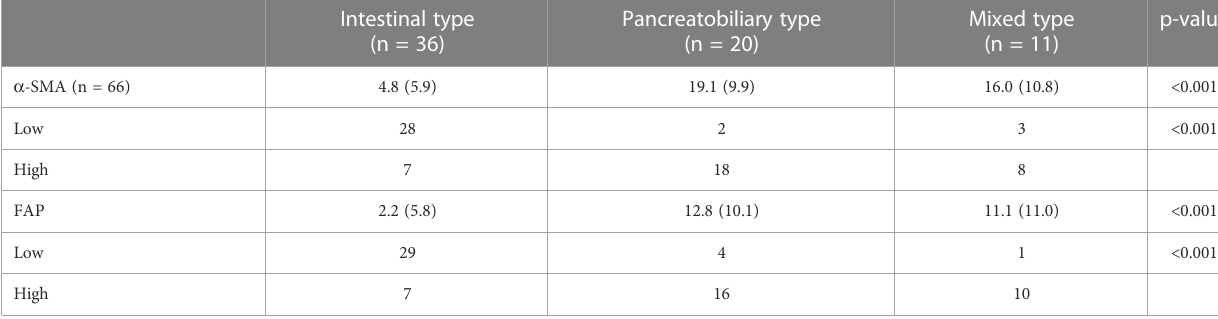
TABLE 2 Association of CAF expression with histopathologic subtype of ampullary